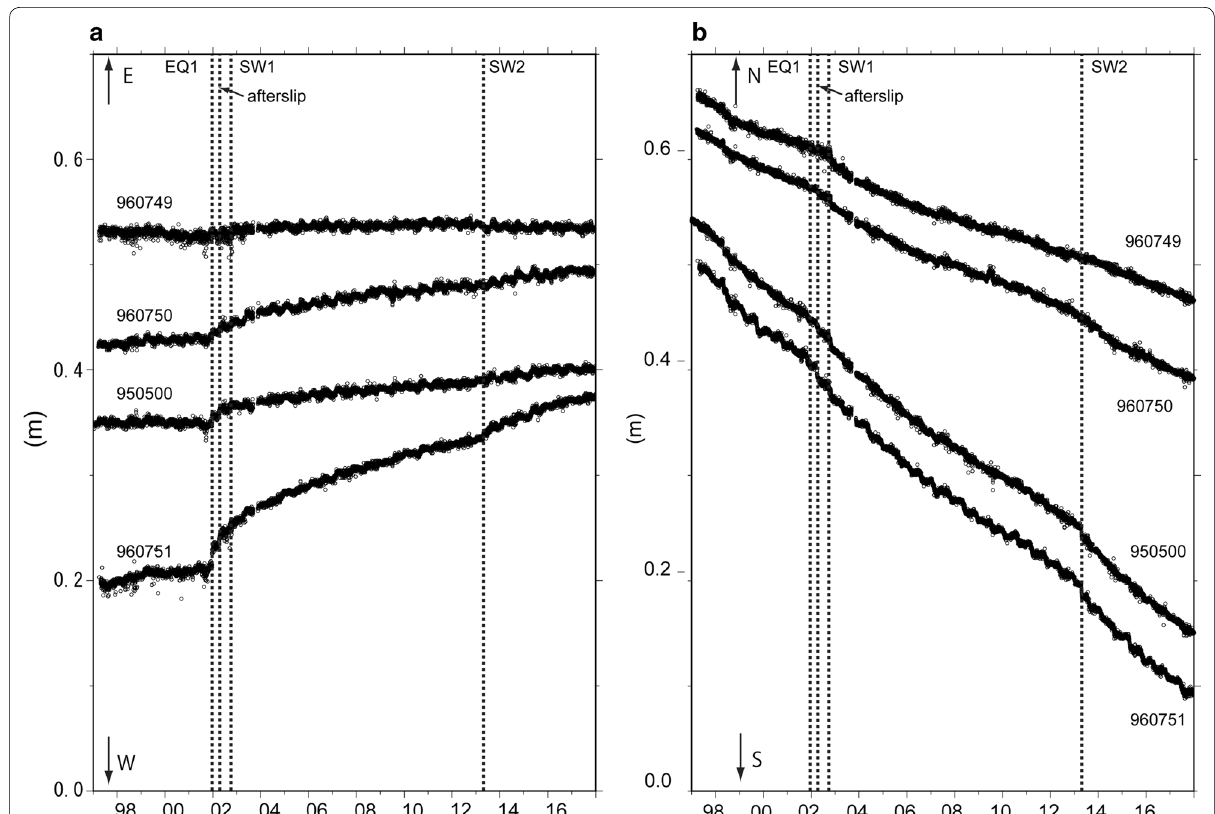
Fig. 4 Time series of the daily coordinates of GNSS sites from January 1997 to December 2017. a East–west component of the time series at each station. The position is relative to site 950498 (Fig. 1b). Dotted lines show the occurrence of the Eq1, afterslip, SW1, and SW2. b The same as a but for the north–south component